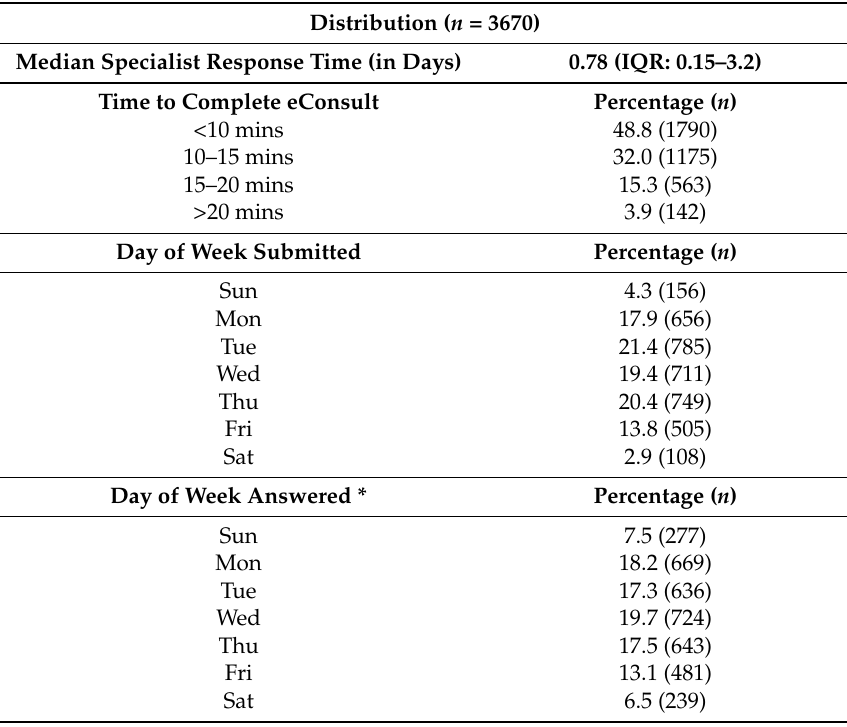
Table 1. Utilization characteristics of eConsults submitted between 1 April 2014 and 31 March